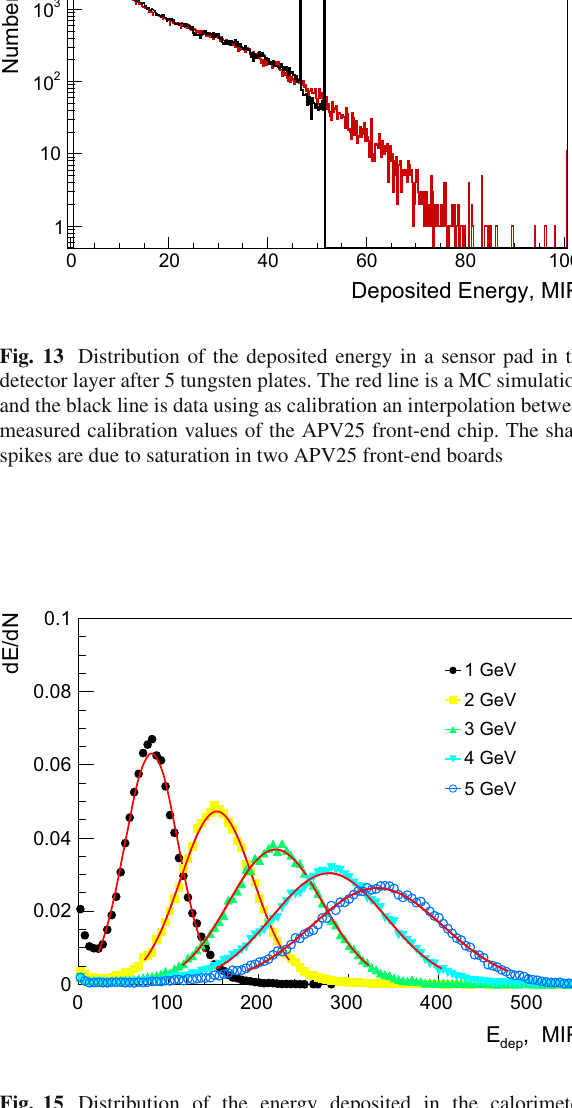
Fig. 16 Average deposited energy in the calorimeter, E dep , as a func- tion of beam energy before (red) and after applying the APV25 cali- bration and corrections to the leakage fraction estimated from the sim- ulation (blue). The lines are straight line fits to the data. The lower part of the figure shows the ratio of the deposited energy to the straight line